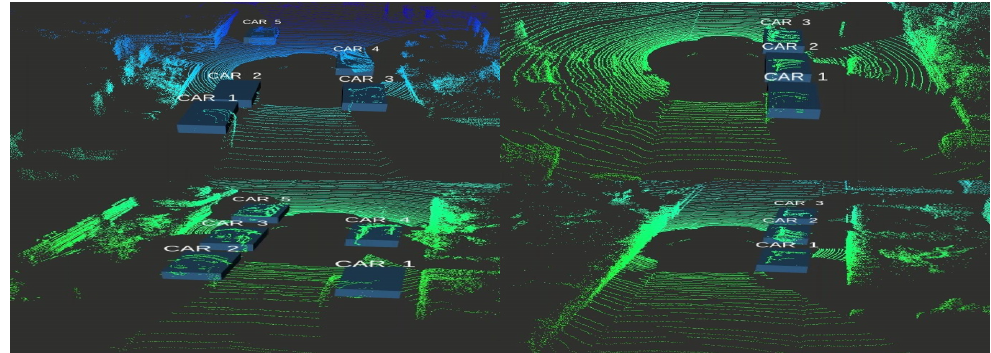
Figure 9. Qualitative results of the proposed model using KITTI 3D object detection dataset in LiDAR frame.